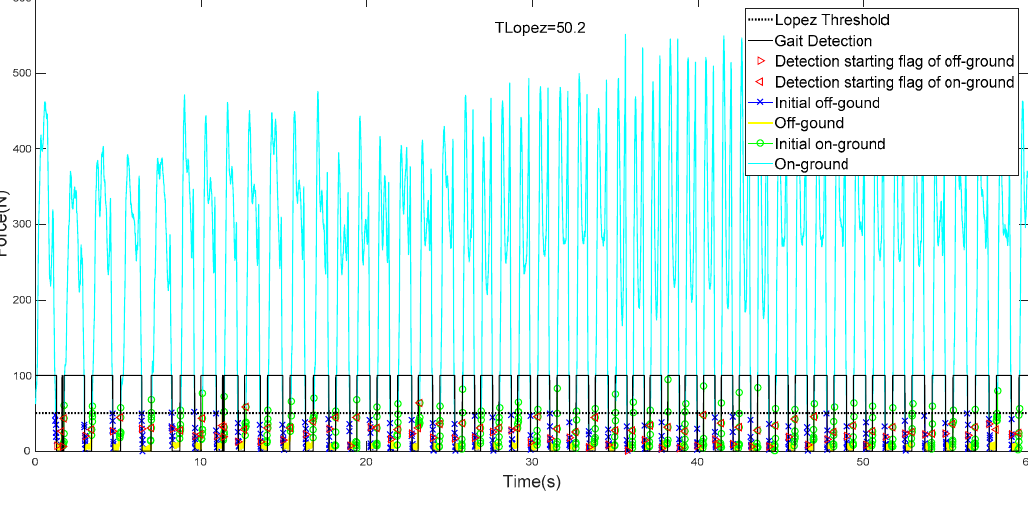
Figure 12. Result of gait phase detection.